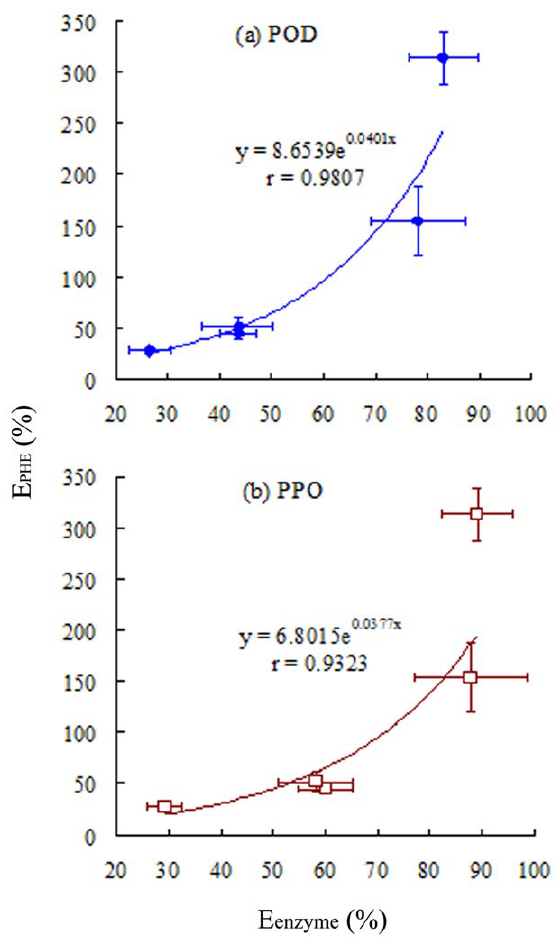
Figure 6. Relationship between E PHE and E enzyme for ( a ) POD and ( b ) PPO. E PHE and E enzyme are the inhibition efficiencies of ascorbic acid on phenanthrene degradation and enzyme activities in plant roots, respectively. E PHE was calculated as: E PHE (%) = (C PHE-AA –C PHE-c )/C PHE- c 6 100%, where C PHE-c and C PHE-AA represent the phenanthrene concentrations in plant roots grown without and with AA, respectively. E enzyme was calculated as: E enzyme = (U c –U AA )/U c 6 100%, where U AA and U c represent the enzyme activities in plant roots grown in the presence and absence of AA, respectively. Error bars represent standard deviations (SD).